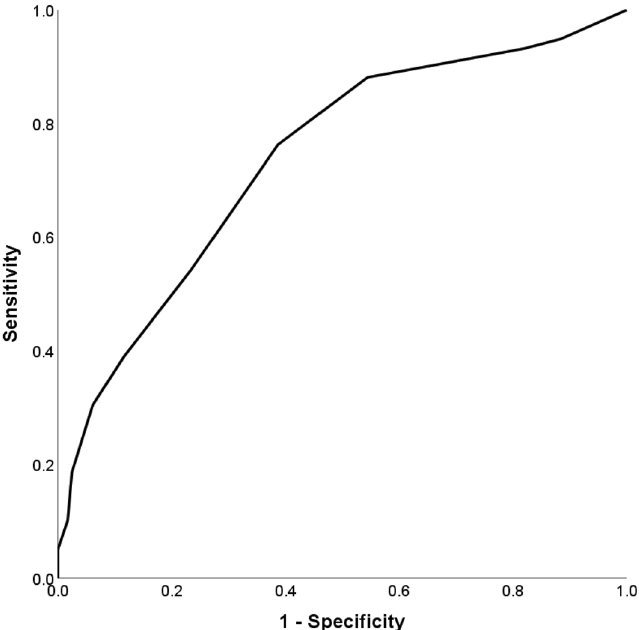
Figure 3. ROC curve showing the performance of the preconception miscarriage risk score in predicting miscarriage. The area under the ROC curve was 0.74 (95% confidence interval 0.67, 0.81; p < 0.001). ROC